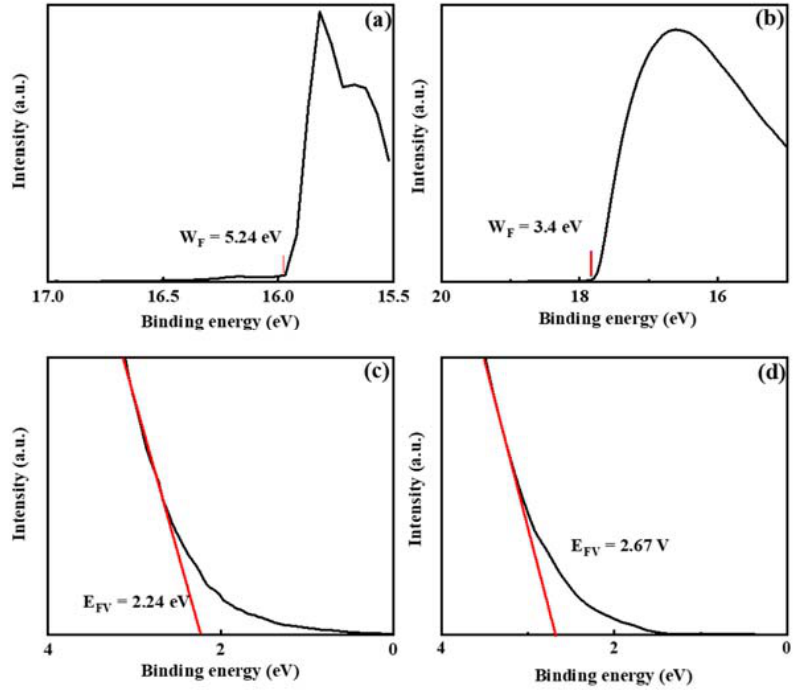
Figure 8. UPS results near the cut-off edge of high binding energy for ( a ) ZnO and ( b ) ZnO:H prepared at H 2 /(Ar + H 2 ) = 0.13%; UPS results near the cut-off edge of low binding energy for ( c ) ZnO and ( d ) ZnO:H prepared at H 2 /(Ar + H 2 ) = 0.13%.